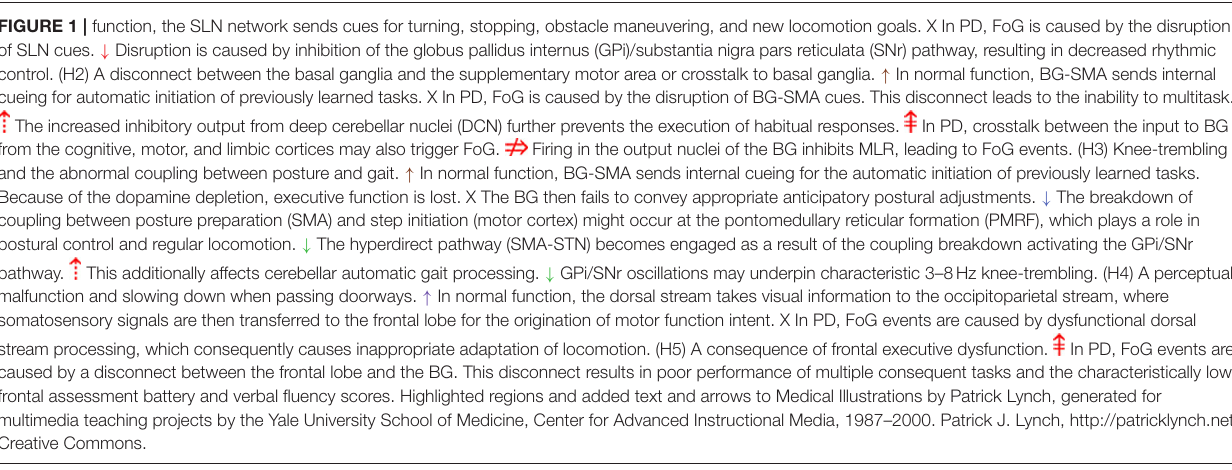
FIGURE 1 | function, the SLN network sends cues for turning, stopping, obstacle maneuvering, and new locomotion goals. X In PD, FoG is caused by the disruption of SLN cues. ↓ Disruption is caused by inhibition of the globus pallidus internus (GPi)/substantia nigra pars reticulata (SNr) pathway, resulting in decreased rhythmic control. (H2) A disconnect between the basal ganglia and the supplementary motor area or crosstalk to basal ganglia. ↑ In normal function, BG-SMA sends internal cueing for automatic initiation of previously learned tasks. X In PD, FoG is caused by the disruption of BG-SMA cues. This disconnect leads to the inability to multitask. The increased inhibitory output from deep cerebellar nuclei (DCN) further prevents the execution of habitual responses. In PD, crosstalk between the input to BG from the cognitive, motor, and limbic cortices may also trigger FoG. Firing in the output nuclei of the BG inhibits MLR, leading to FoG events. (H3) Knee-trembling and the abnormal coupling between posture and gait. ↑ In normal function, BG-SMA sends internal cueing for the automatic initiation of previously learned tasks. Because of the dopamine depletion, executive function is lost. X The BG then fails to convey appropriate anticipatory postural adjustments. ↓ The breakdown of coupling between posture preparation (SMA) and step initiation (motor cortex) might occur at the pontomedullary reticular formation (PMRF), which plays a role in postural control and regular locomotion. ↓ The hyperdirect pathway (SMA-STN) becomes engaged as a result of the coupling breakdown activating the GPi/SNr pathway. This additionally affects cerebellar automatic gait processing. ↓ GPi/SNr oscillations may underpin characteristic 3–8Hz knee-trembling. (H4) A perceptual malfunction and slowing down when passing doorways. ↑ In normal function, the dorsal stream takes visual information to the occipitoparietal stream, where somatosensory signals are then transferred to the frontal lobe for the origination of motor function intent. X In PD, FoG events are caused by dysfunctional dorsal stream processing, which consequently causes inappropriate adaptation of locomotion. (H5) A consequence of frontal executive dysfunction. In PD, FoG events are caused by a disconnect between the frontal lobe and the BG. This disconnect results in poor performance of multiple consequent tasks and the characteristically low frontal assessment battery and verbal fluency scores. Highlighted regions and added text and arrows to Medical Illustrations by Patrick Lynch, generated for multimedia teaching projects by the Yale University School of Medicine, Center for Advanced Instructional Media, 1987–2000. Patrick J. Lynch, http://patricklynch.net Creative